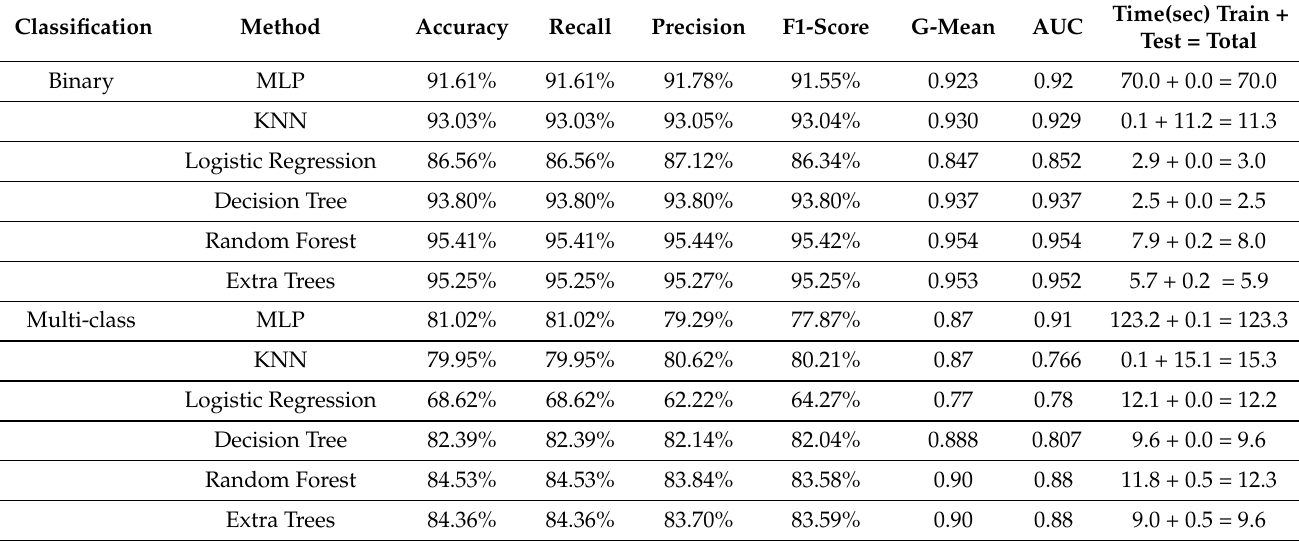
Table 5. Classification results on GAN dataset using chi-square features